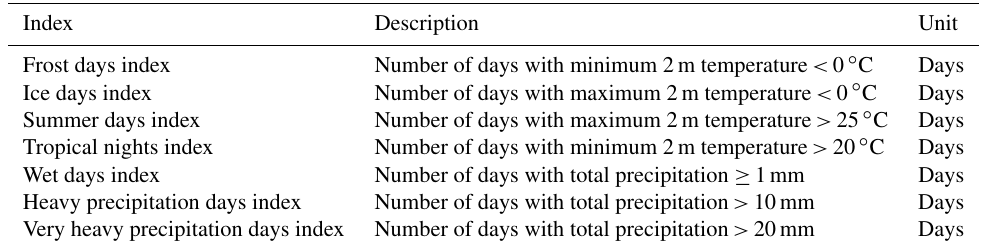
Table 3. Description of climate